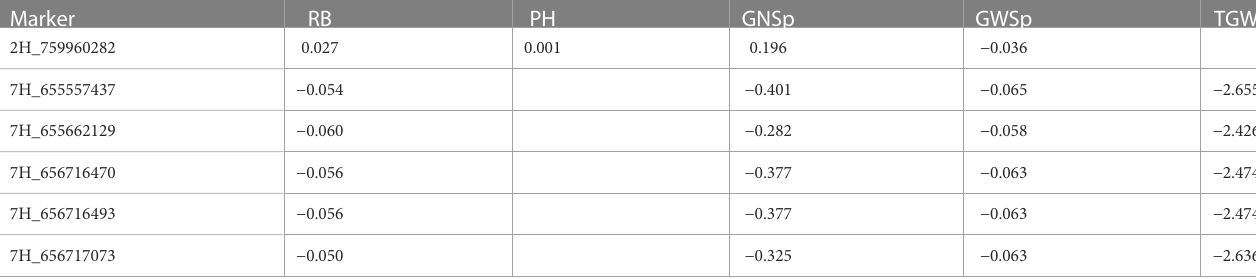
TABLE 6 Markers signi fi cantly associated with four phenotypic traits and their allele substitution effects. Marker RB PH GNSp GWSp